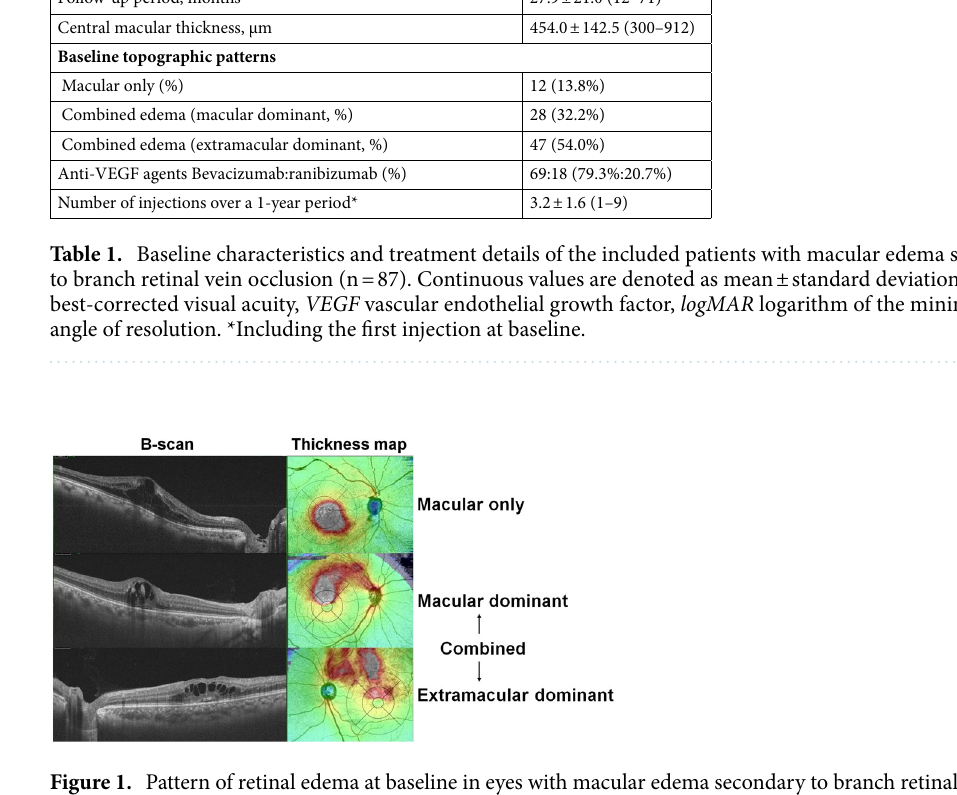
Figure 1. Pattern of retinal edema at baseline in eyes with macular edema secondary to branch retinal vein occlusion (BRVO). All horizontal B-scans across the fovea shows cystoid macular edema. However, the extent and topographic features of retinal edema vary from edema exclusively in the macula ( A ) and combined extramacular and macular edema ( B , C ). Depending on the dominant area of edema (white or red areas), eyes with combined edema were separated into macular dominant ( B ) and extramacular dominant edema ( C